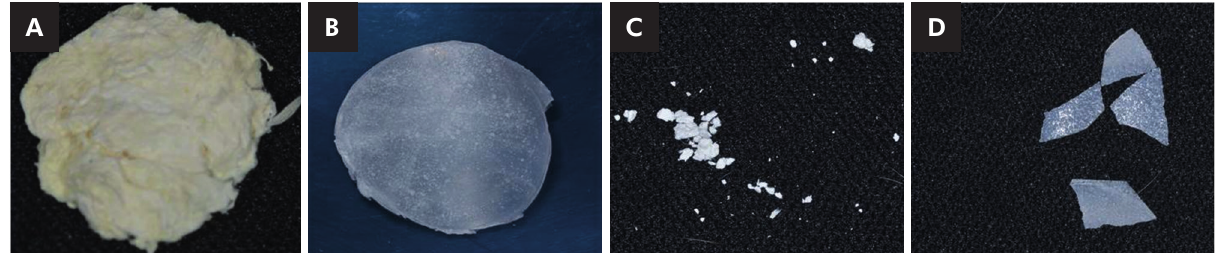
Figure 5. Polymeric